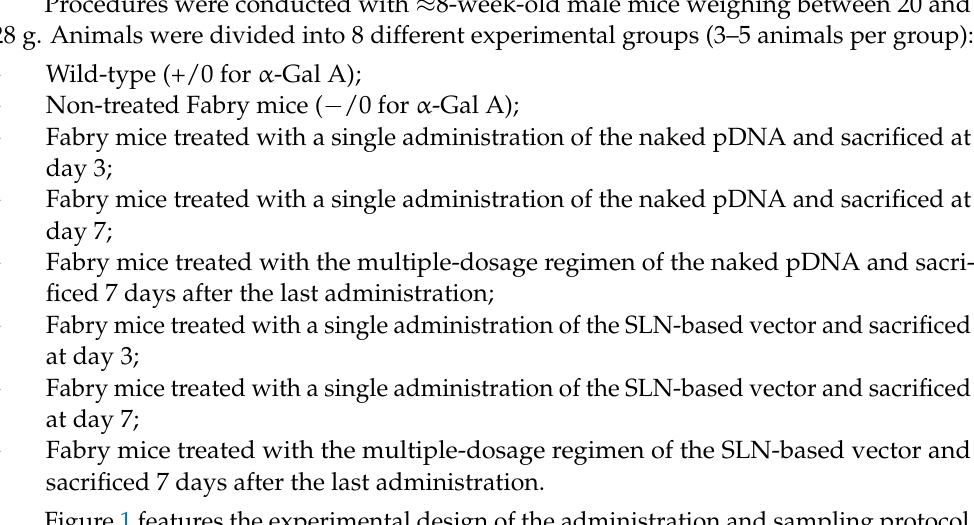
Figure 1 features the experimental design of the administration and sampling